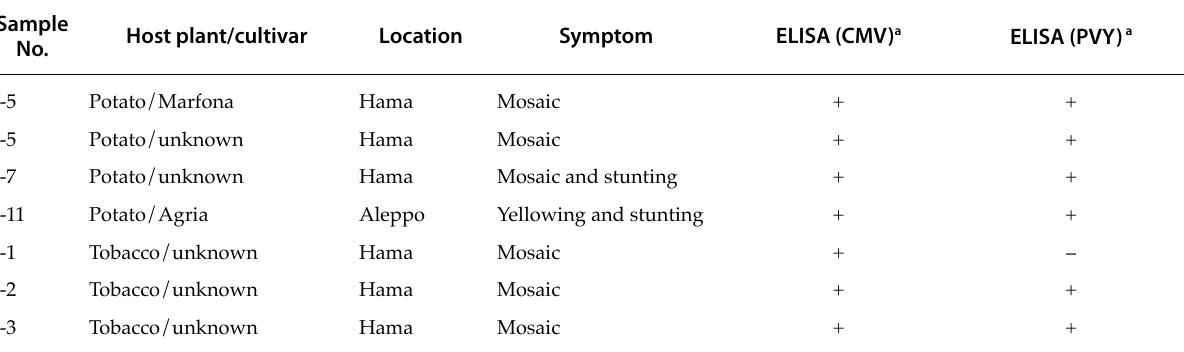
Table 1. Potato and tobacco samples infected with CMV. Sample